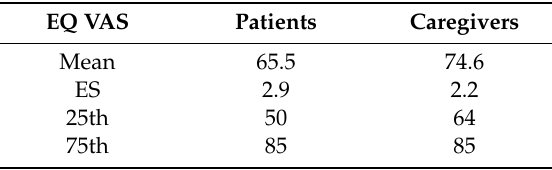
Table 3. EQ 5D VAS value for patients and caregivers.